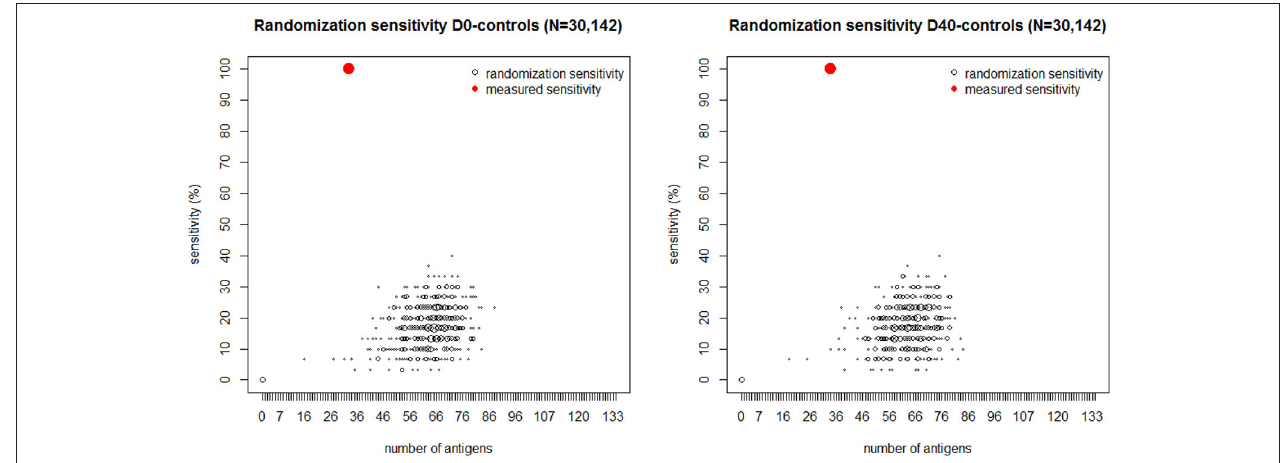
FIGURE 5 | Black dots: number of antigens (horizontal axis) selected by the logistic regression plotted vs. its sensitivity (vertical axis) generated by randomly mismatching the measured IgG profiles measured at D0 ( Left ) and D40 ( Right ) and in the controls from their corresponding SSTI infection status. The size of each dot is proportional to the frequency of its coordinate values over 10,000 randomizations. The red dot in each figure panel shows the number of antigens and corresponding sensitivity obtained by fitting the logistic regression to the IgG data and their corresponding SSTI infection status. The absence of black dots near the red dots shows that the probability that 100% sensitivity could be achieved by chance is numerically zero. These results lead us to reject the null hypothesis that the association between SSTI infection status and IgG profiles is not statistically